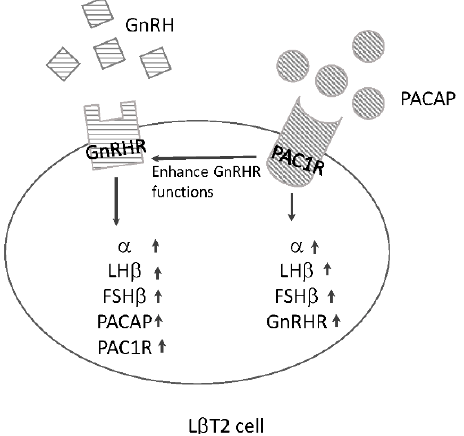
Figure 2. Schematic summary of the action of GnRH and PACAP in pituitary gonadotrophic L β T2 cells. In static cultures of L β T2 cells, both GnRH and PACAP increase the expression of gonadotropin α -, LH β - and FSH β -subunits. GnRH stimulates the expression of PACAP and its receptor PAC1R, while GnRH receptor expression is stimulated by PACAP. The presence of PAC1R enhances GnRH’s effects on gonadotropin expression.